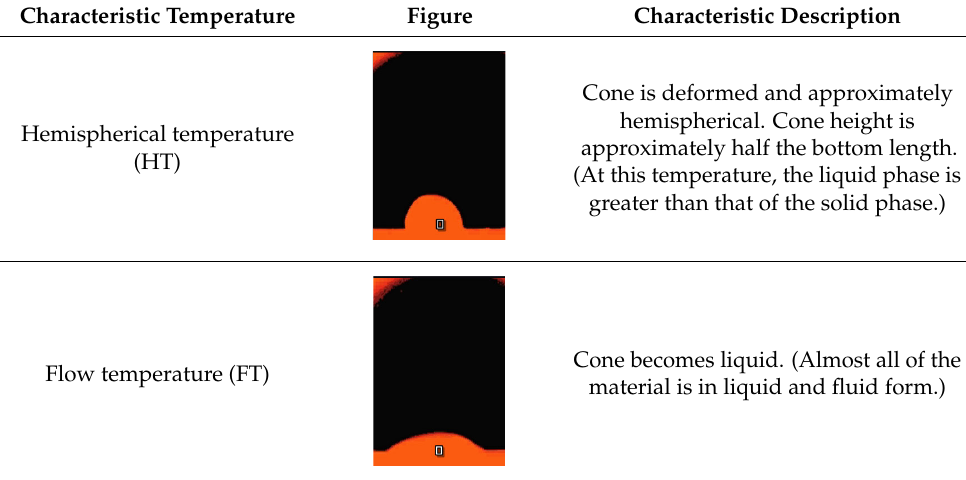
Cone becomes liquid. (Almost all of the material is in liquid and fluid